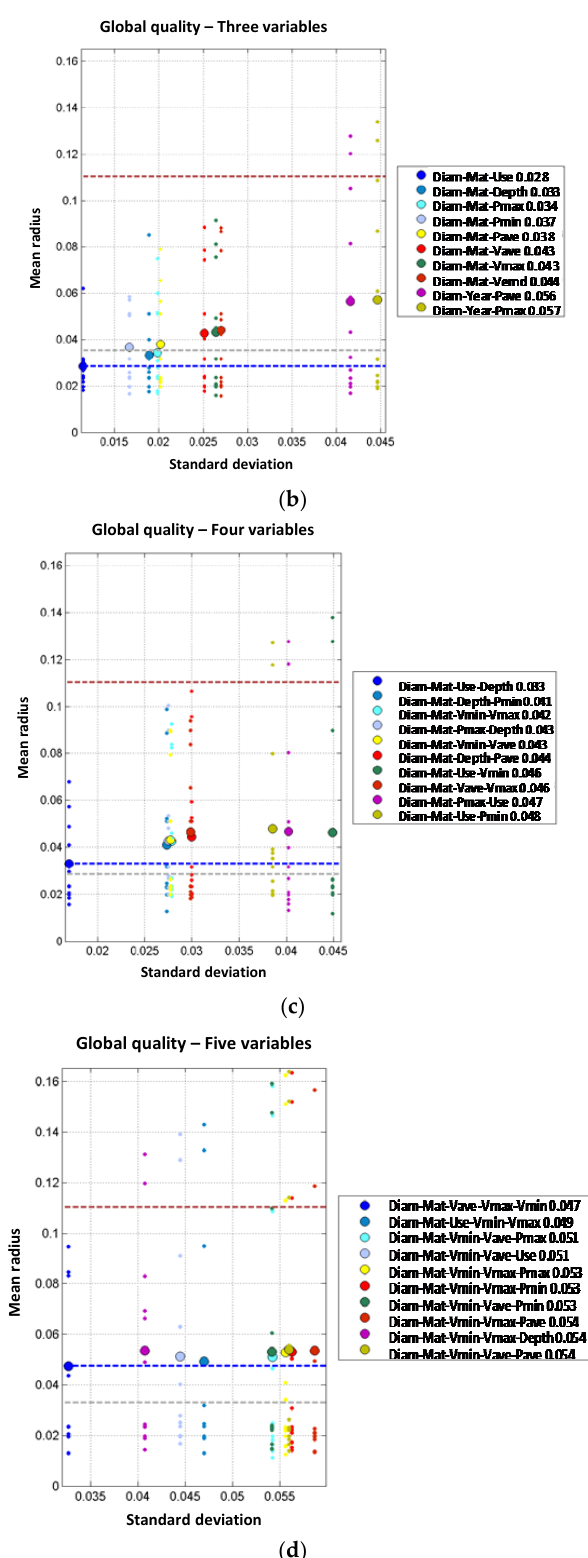
Figure 6. Trunk mains. Mean radius and standard deviation for models with all independent variables. 2 Order zero mean radius is represented with brown dotted line; and best predictive model with blue line for: ( a ) order two; ( b ) order three; ( c ) order four and ( d ) order five